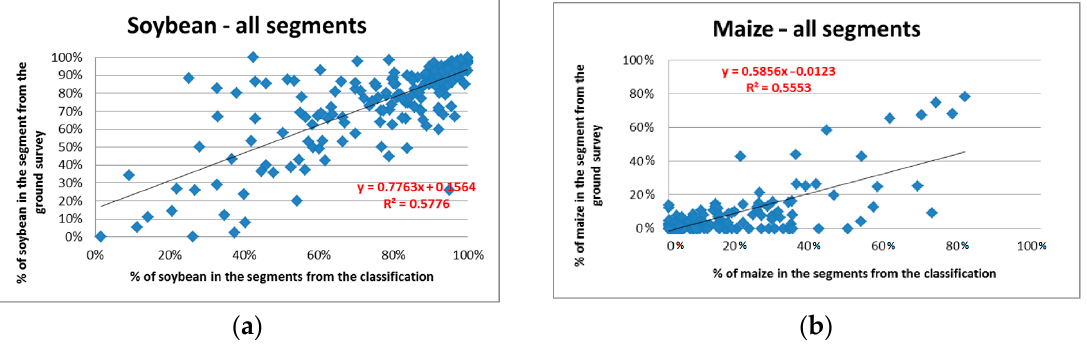
Figure 5. Regressions of crop proportions for the soybean ( a ) and maize ( b ) derived from 202 surveyed segments against those derived from the classification for the same segments. Table 3. Crop area proportions derived from a ground survey, image classification, and the regression estimator. SD = standard deviation.